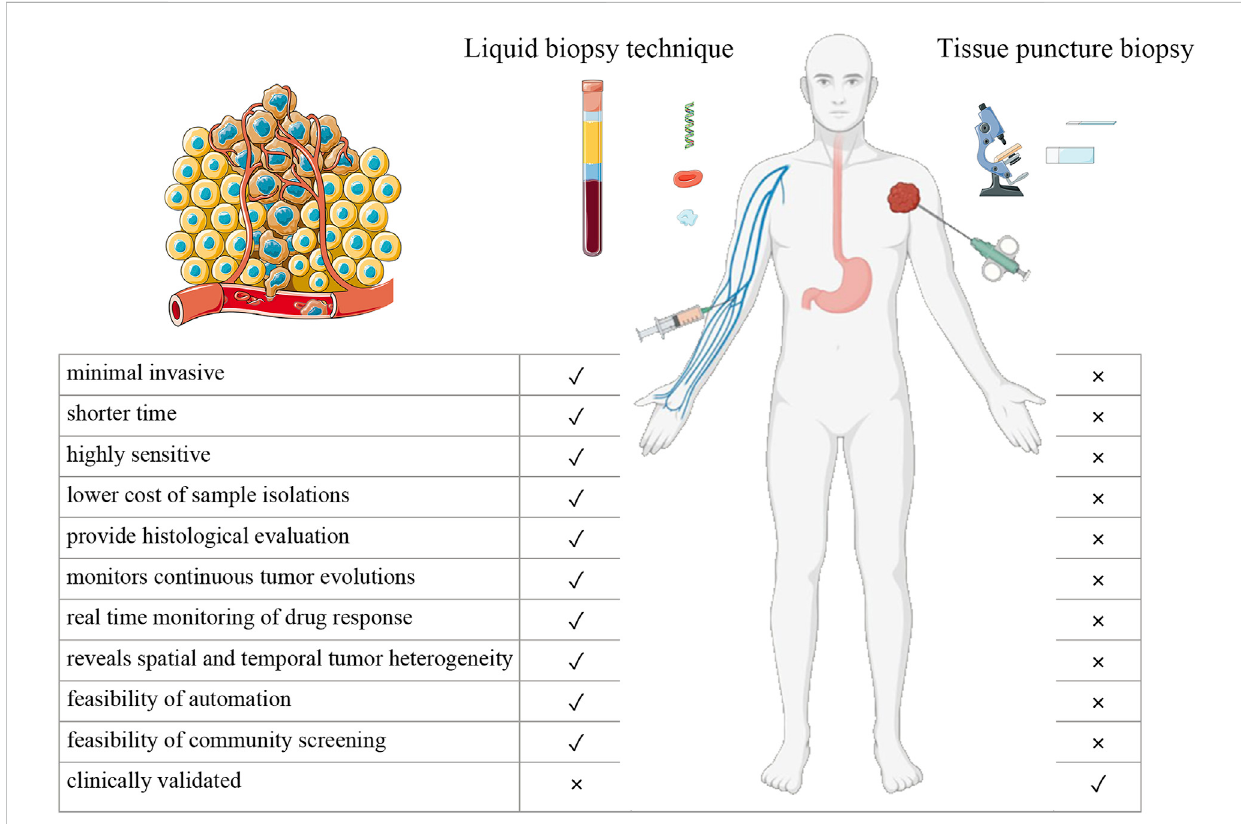
Differences between liquid biopsy technique and tissue puncture